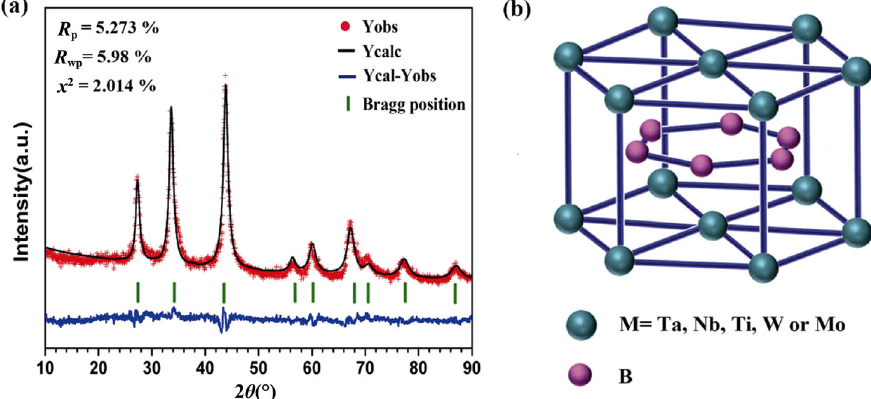
Fig. 2 (a) XRD pattern along with Rietveld refinement for the as-synthesized HEB-1 products at 1423 K; (b) the crystal structure of the as-synthesized HEB-1